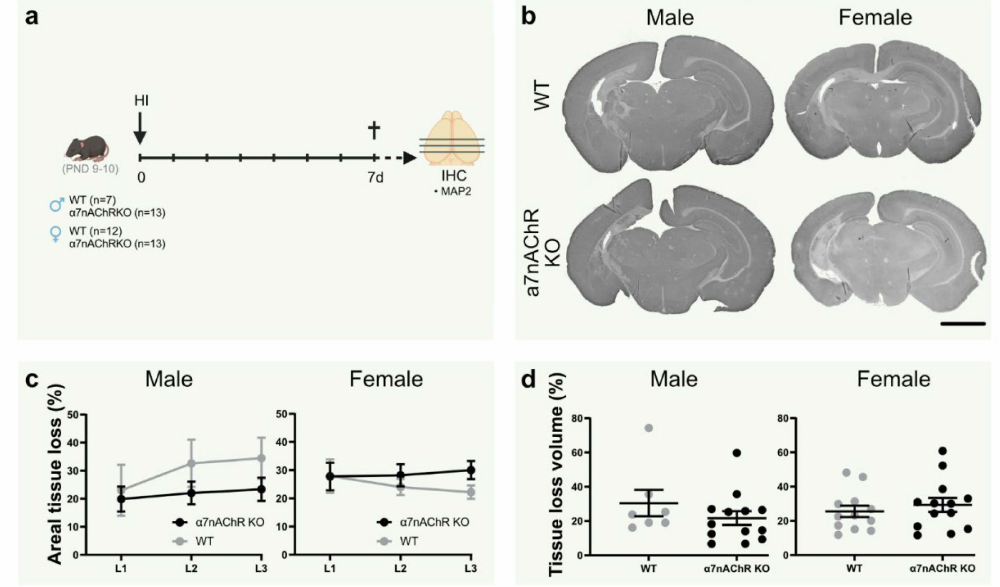
Figure 3. Knock-out of α 7nAChR does not affect tissue loss in neonatal hypoxic-ischemic brain injury. ( a ) Experimental timeline. Male ( left ; n = 7–13 per group) and female ( right ; n = 12–13 per group) α 7nAChR knock-out (KO; black) and wild-type (WT) littermate control (gray) pups were subject to hypoxia-ischemia (HI) on postnatal day (PND) 9–10, and sacrificed after 7 days. ( b ) Representative micrographs (1.25 × ) of coronal sections (level 1) stained with the neuron dendrite marker MAP2. ( c ) Areal tissue loss (%) at coronal levels (caudal-rostral direction) of the brain 7 d after HI. ( d ) Tissue loss volume (%) in the brain 7 d after HI. Data are expressed as mean ± SEM. p < 0.05 was considered significant. Scale bar: 2